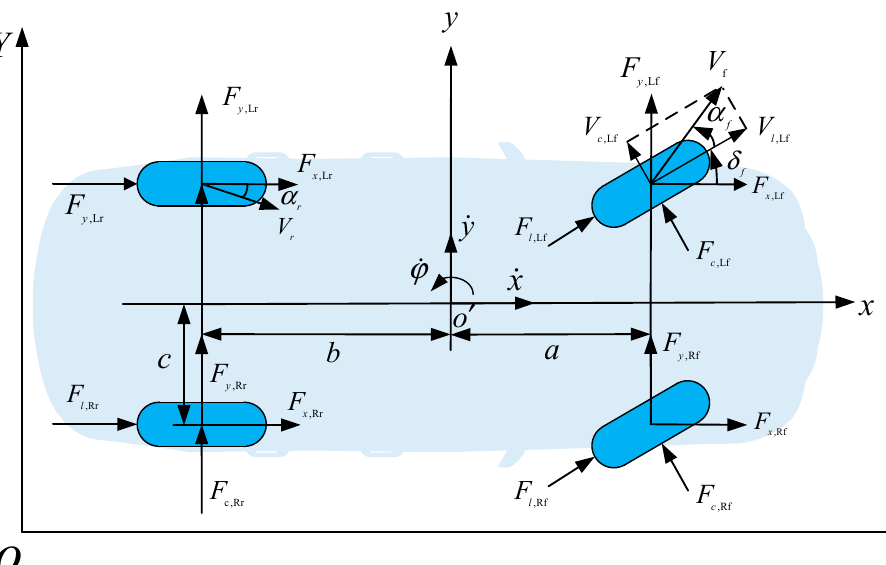
Figure 1. Vehicle dynamics model.